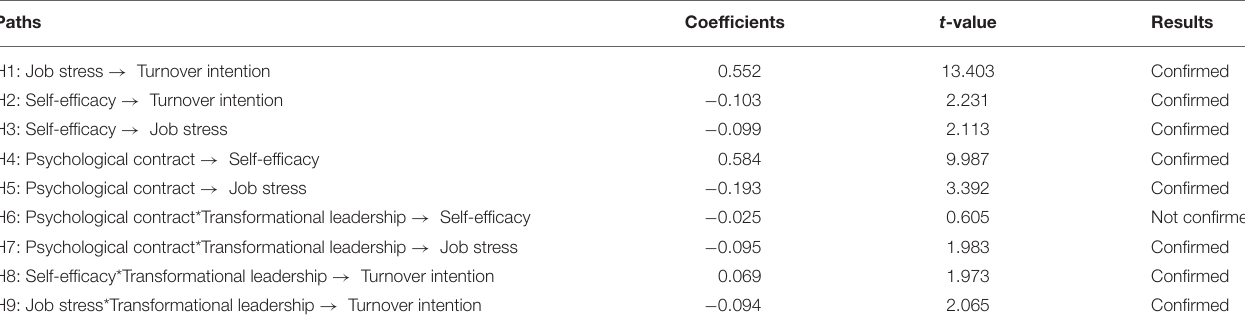
TABLE 2 | Results of hypotheses testing. Paths